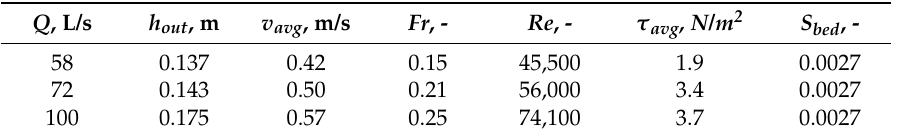
Table 1. Hydraulic features of each run.